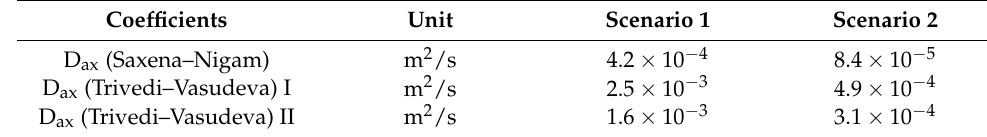
Table 4. Axial dispersion coefficients for the discussed PFR